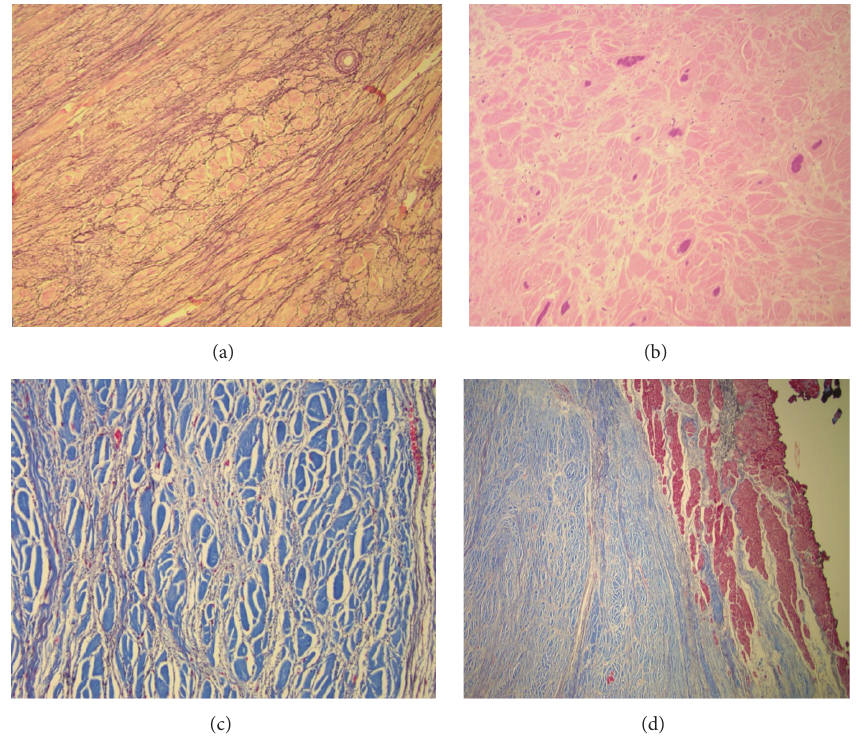
Figure 3: Histologic slides of the cardiac fibroma revealing numerous elastic fibers (a) and calcific stippling (b). Trichrome staining (c and d) revealed well demarcation from the interface of the tumor with the normal myocardium (red) and showed groups of fascicles of collagen (blue) surrounded by black-staining elastic